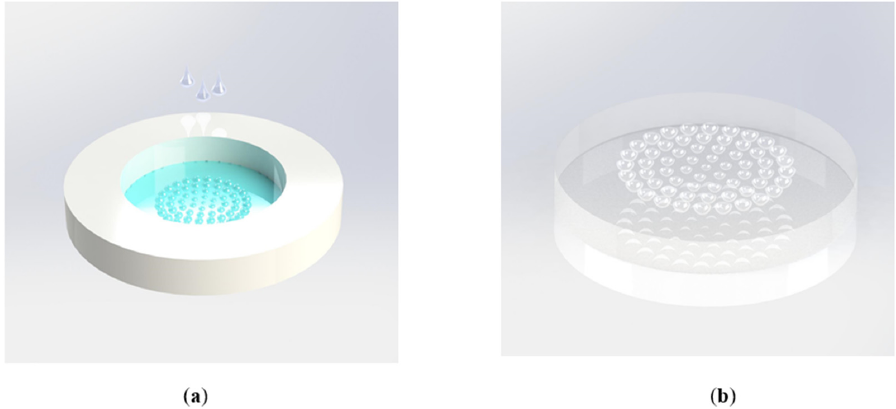
Figure 6. ( a ) Schematic illustration of the soft lithography process; ( b ) the fabricated PDMS film with concave MLA.